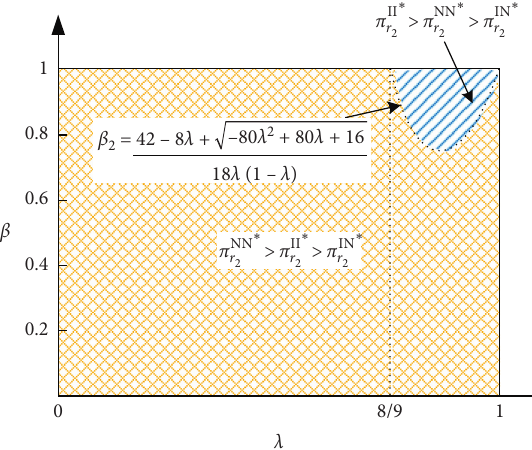
Figure 6: Comparison of R